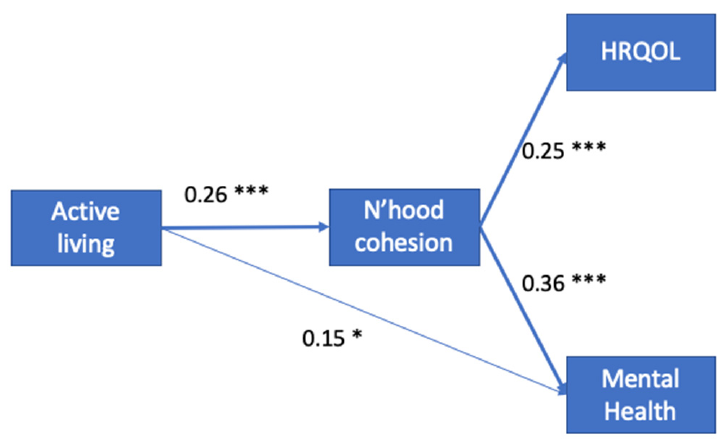
Figure 1. Mediation analysis through neighborhood cohesion. Path coefficients are shown. (n = 270; *** p < 0.001; ** p < 0.01; * p < 0.05).